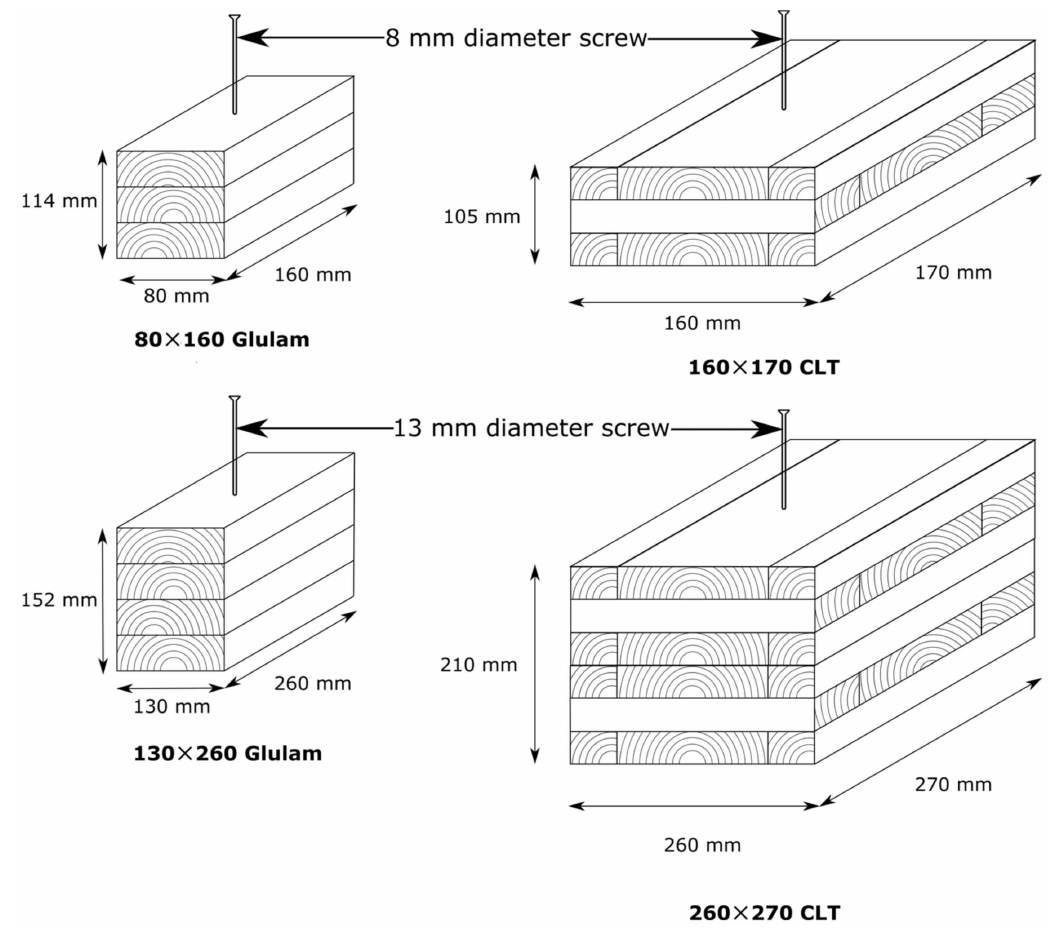
Figure 1. CLT and glulam configurations with 8 mm screw ( top row ) and 13 mm screw ( bottom row ). Table 1. Finite element model configurations and moisture content